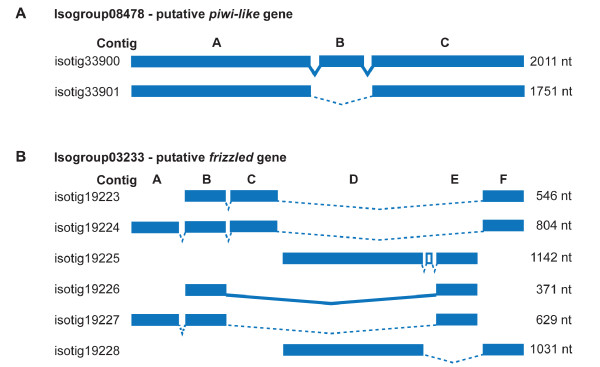
Validation of transcript assembly for two isogroups. Contigs and isotigs produced by the assembly are shown for two isogroups, (A) a putative piwi-like gene and (B) a putative frizzled gene. Blue boxes represent major contigs and V-shaped lines connect contigs that are adjacent to each other within the isotig. Short contigs of only a few nucleotides are omitted in this representation. Contigs that were independently confirmed by PCR and sequencing are represented as filled blue boxes (as opposed to open boxes) and connections between contigs that were independently confirmed by PCR and sequencing are indicated by solid V-shaped lines (as opposed to dotted lines). All major contigs and one isotig for each gene (isotigs 33900 (A) and 19226 (B)) were validated. Nucleotide sequence alignments are provided in Additional file 4.